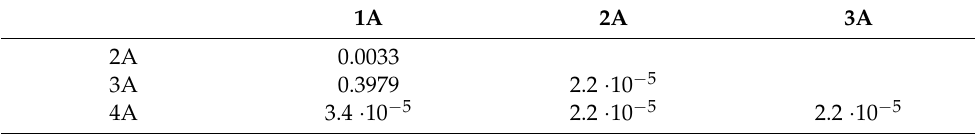
Table 14. Wilcoxon rank-sum test results for tribological wear in individual groups.